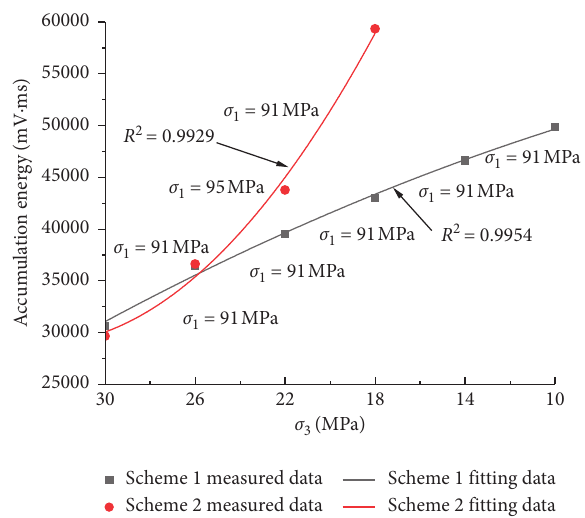
Figure 11: Fitting curve of cumulative AE energy and confining pressure.